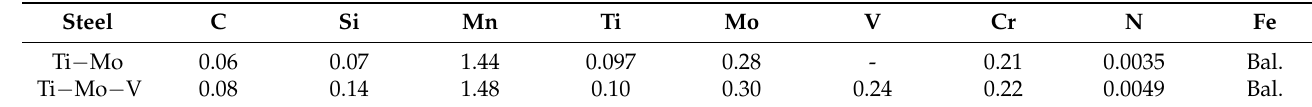
Table 1. Chemical compositions of experimental steels (wt.%).